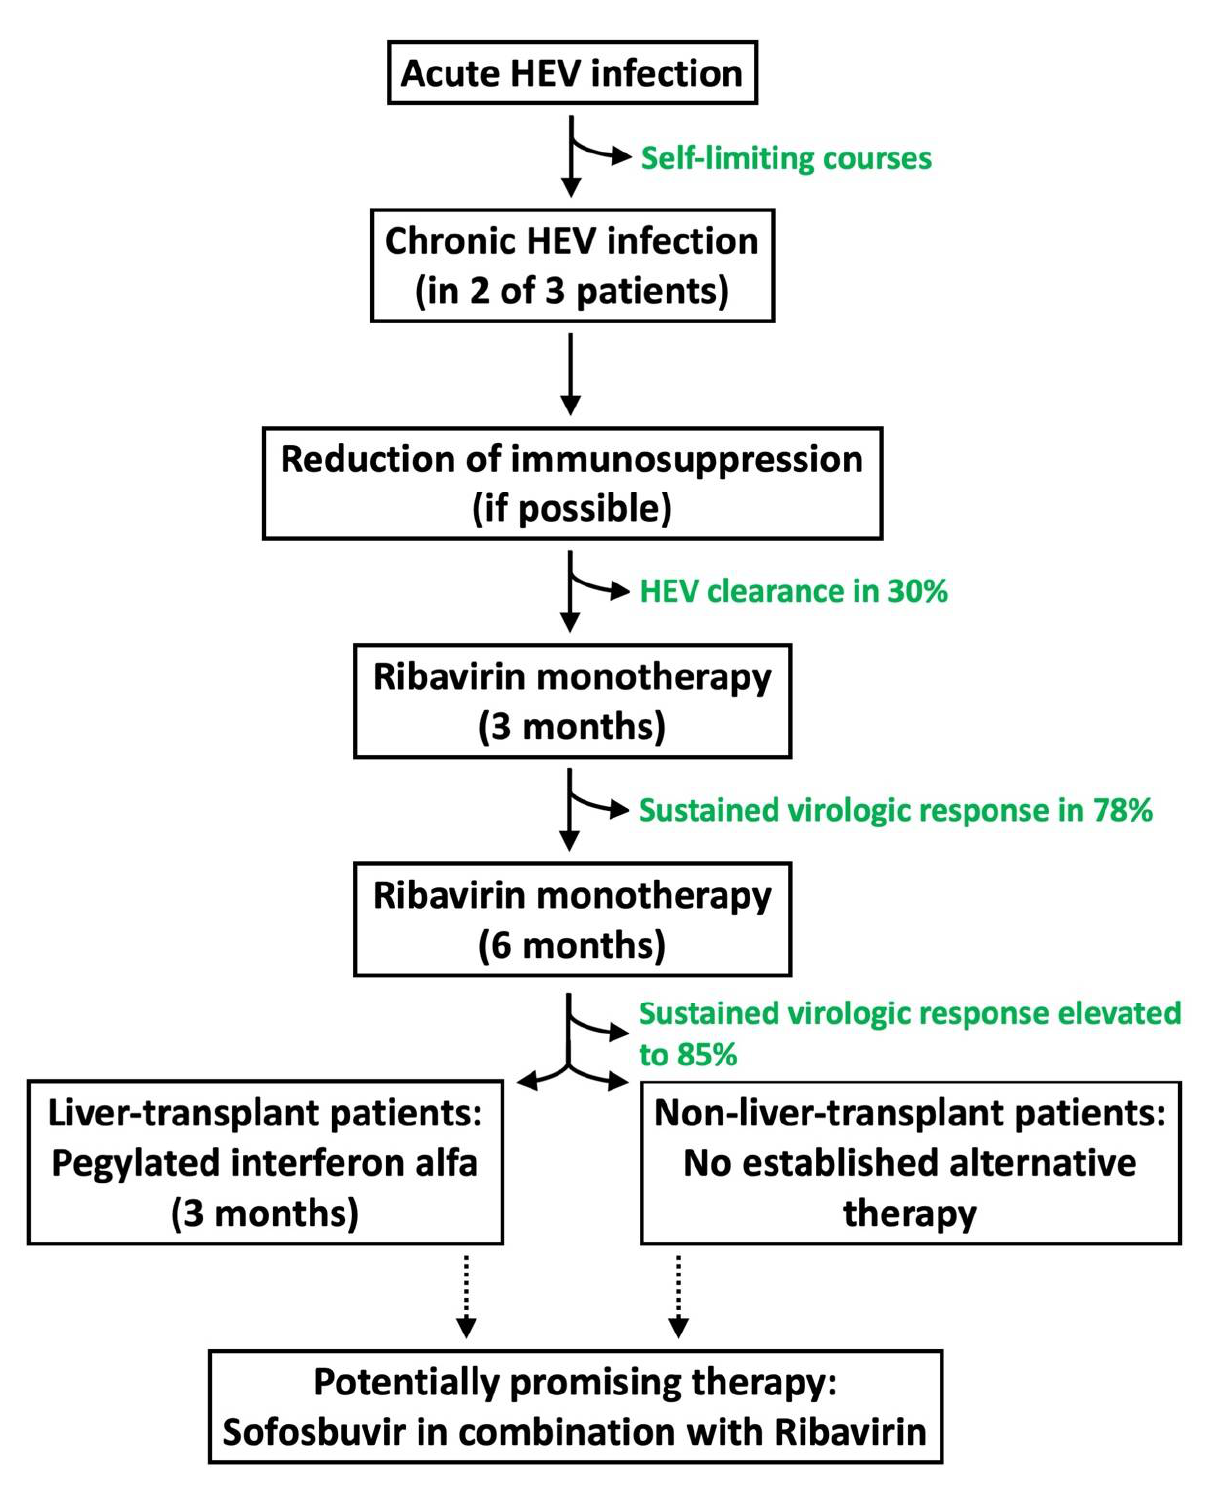
Figure 2. Therapy algorithm for chronic HEV-infected immunosuppressed patients.